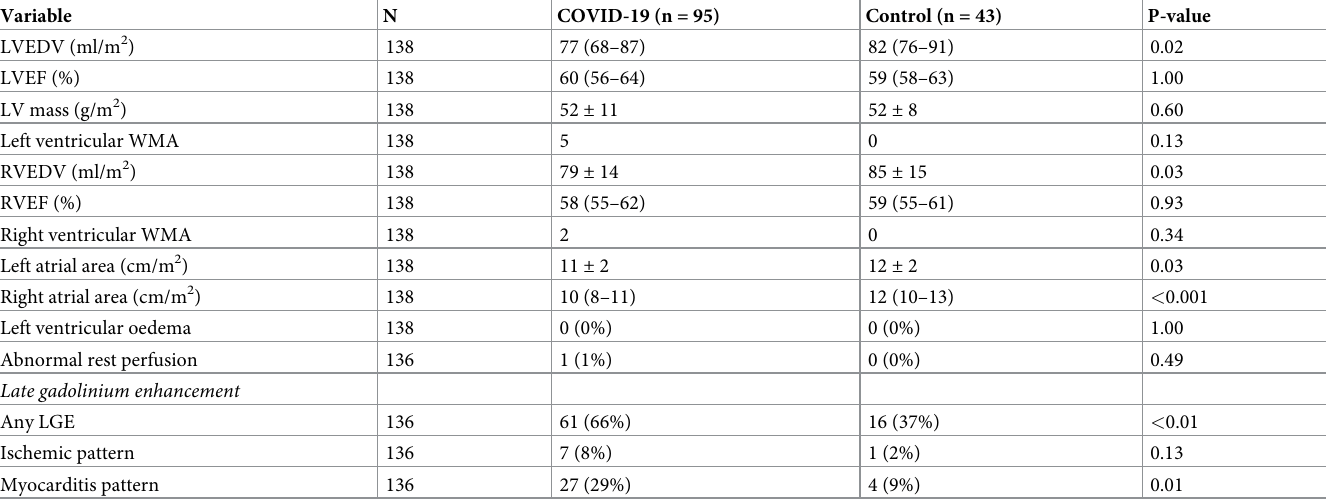
Data are presented as number of patients (%) or mean ± SD, or median (interquartile range). LGE = late gadolinium enhancement; LV = left ventricular; LVEDV = left ventricular end-diastolic volume; LVEF = left ventricular ejection fraction; RVEDV = right ventricular end-diastolic volume; RVEF = right ventricular ejection fraction; WMA = wall motion